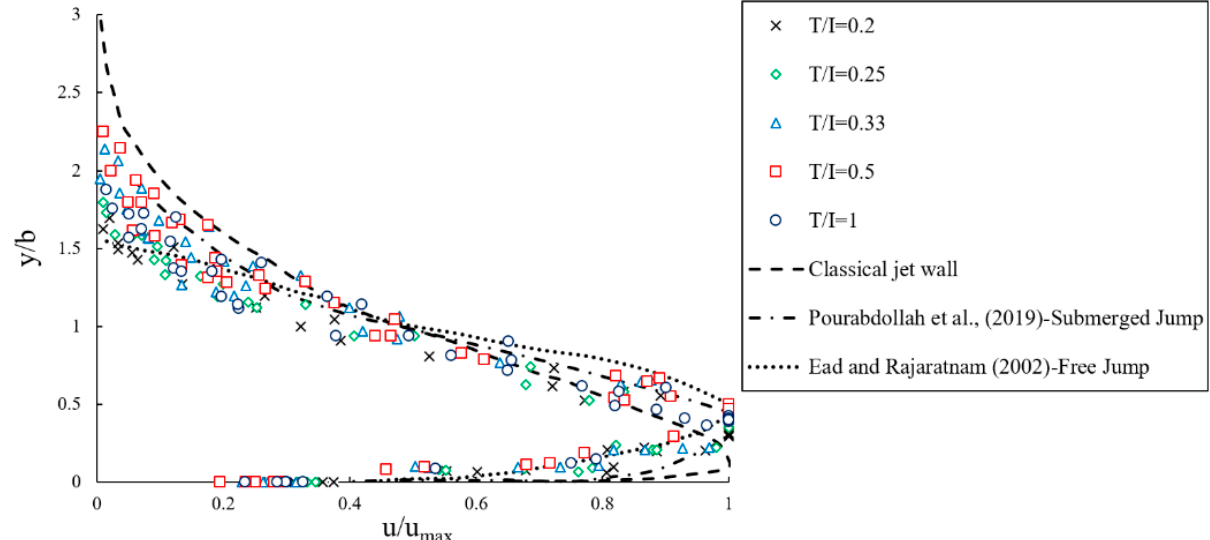
Figure 14. Dimensionless horizontal velocity distribution in the submerged hydraulic jump for different Froude numbers in triangular macroroughnesses.